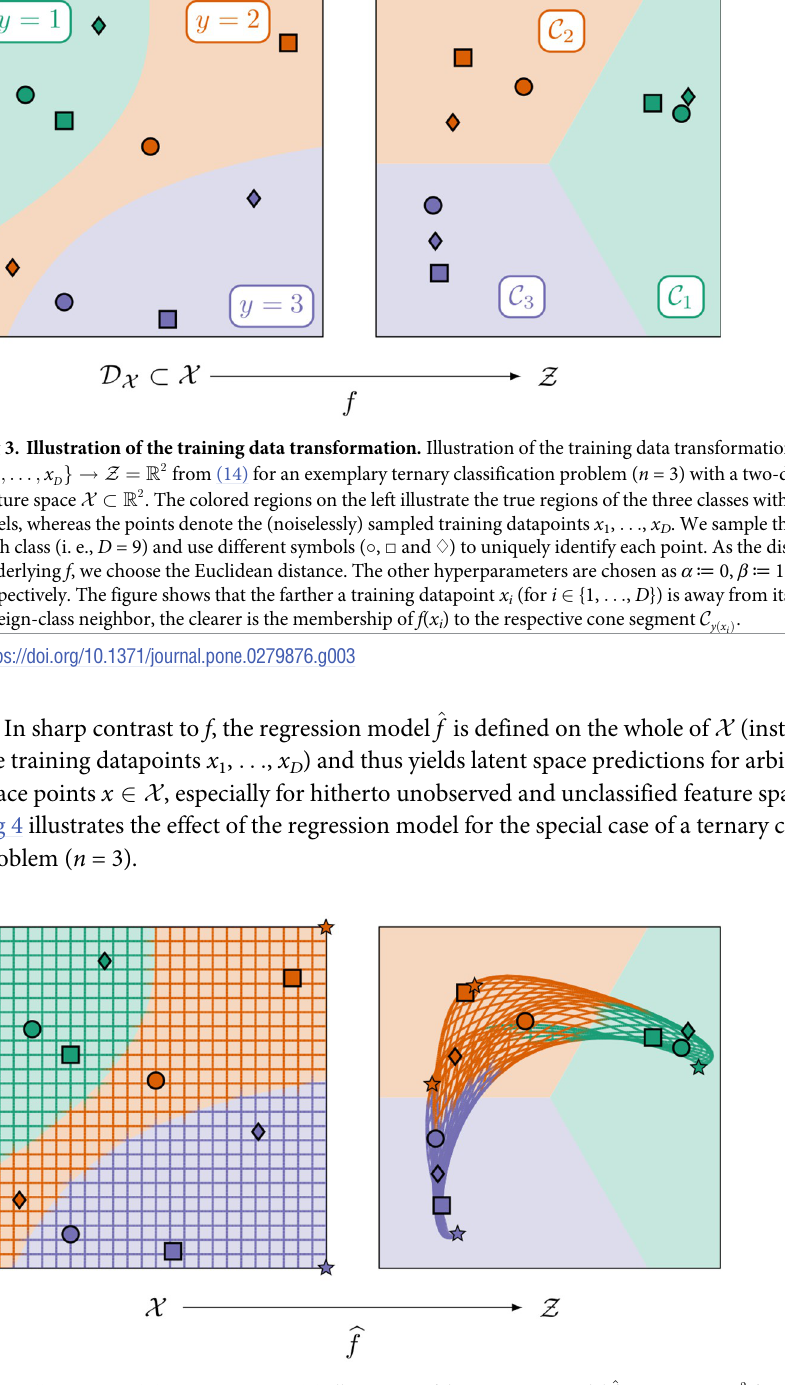
Fig 4. Illustration of the regression model. Illustration of the regression model ^ f : X ! Z ¼ R 2 for the exemplary ternary classification problem from Fig 3. We choose a GPR model with a Mate´rn kernel, which is fitted to the transformed training datapoints ( x 1 , f ( x 1 ),, ... , ( x , f ( x )) that are obtained from the training data transformation f D D according to Fig 3. In order to illustrate the effect of ^ f , we show how the points of the rectangular grid on the left get transformed by ^ f . In particular, we show this transformation for the corner points marked by stars. The color of any point x on the grid and, respectively, of any point ^ f ð x Þ on the transformed grid indicates the true class of x .